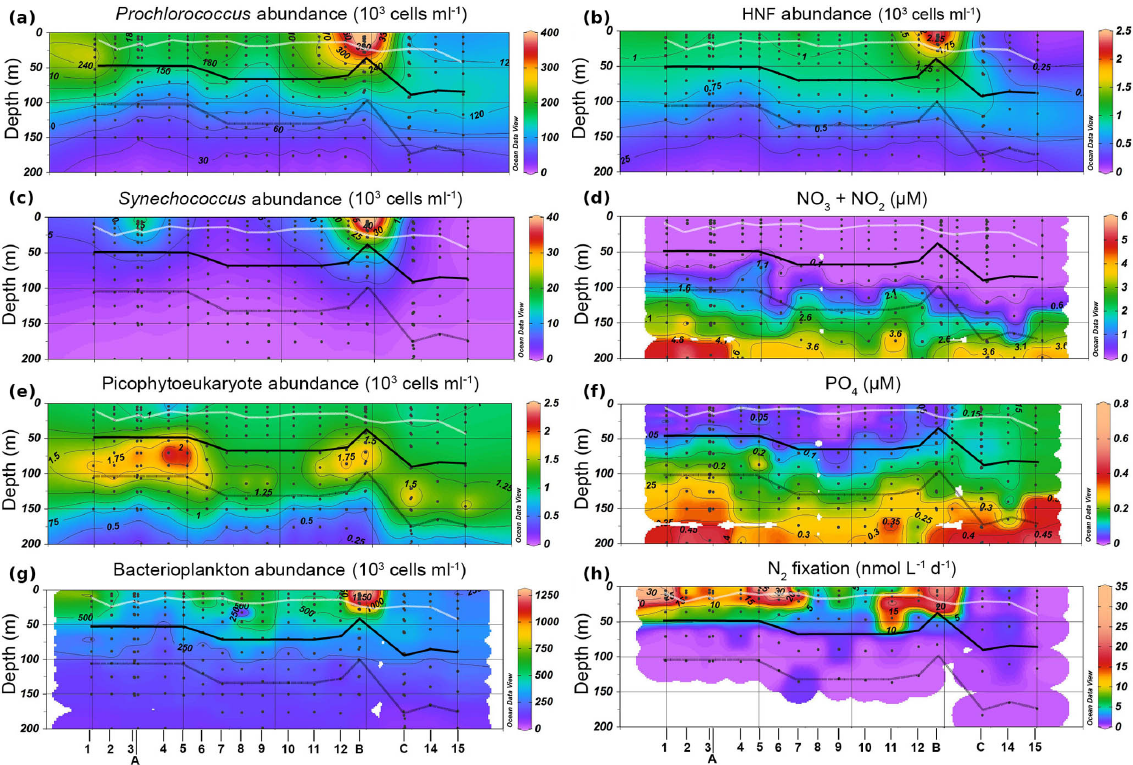
Figure 2. Contour plots depicting plankton abundances (a, b, c, d, e) , nutrient concentrations (f, g) and N 2 fixation (h) distributions along the OUTPACE transect. White line represents the mixed layer depth. The black solid line represents the PAR 2 . 7 depth. Grey line represents PAR 0 . 1